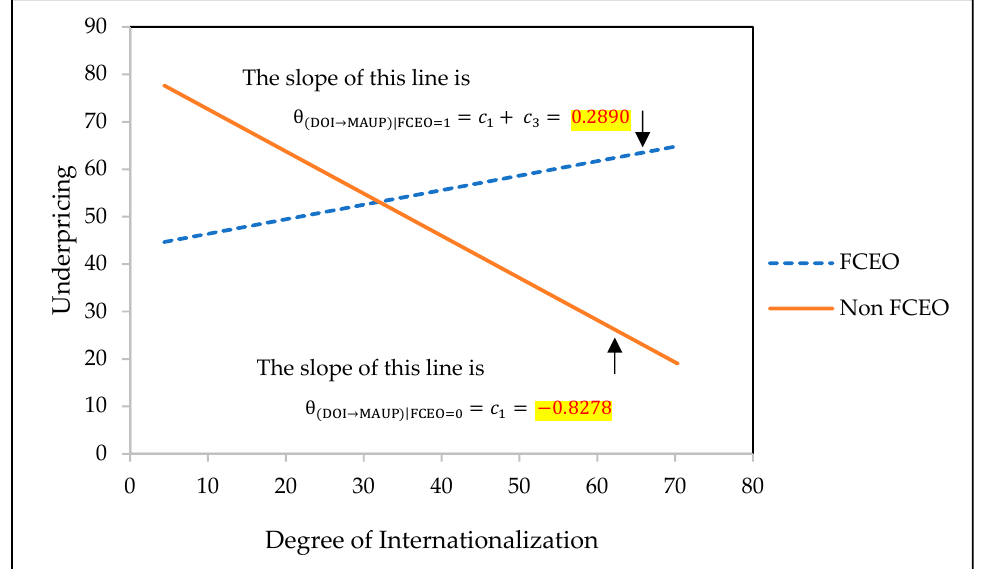
Figure 3. A visual representation of the moderation of the effect of DOI on IPO underpricing by the founders’ role: founder CEO (FCEO = 1) and non - founder CEO (FCEO = 0) .